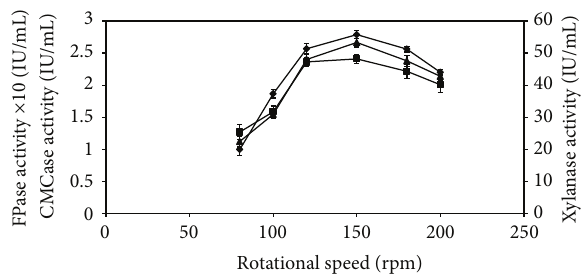
Figure 5: Effect of rotational speed on CMCase,FPase, and xylanase activities. Results are presented as the mean of three replicates with standard deviation: ( Q ) FPase; ( ◼ ) CMCase; ( 󳵳 ) xylanase.